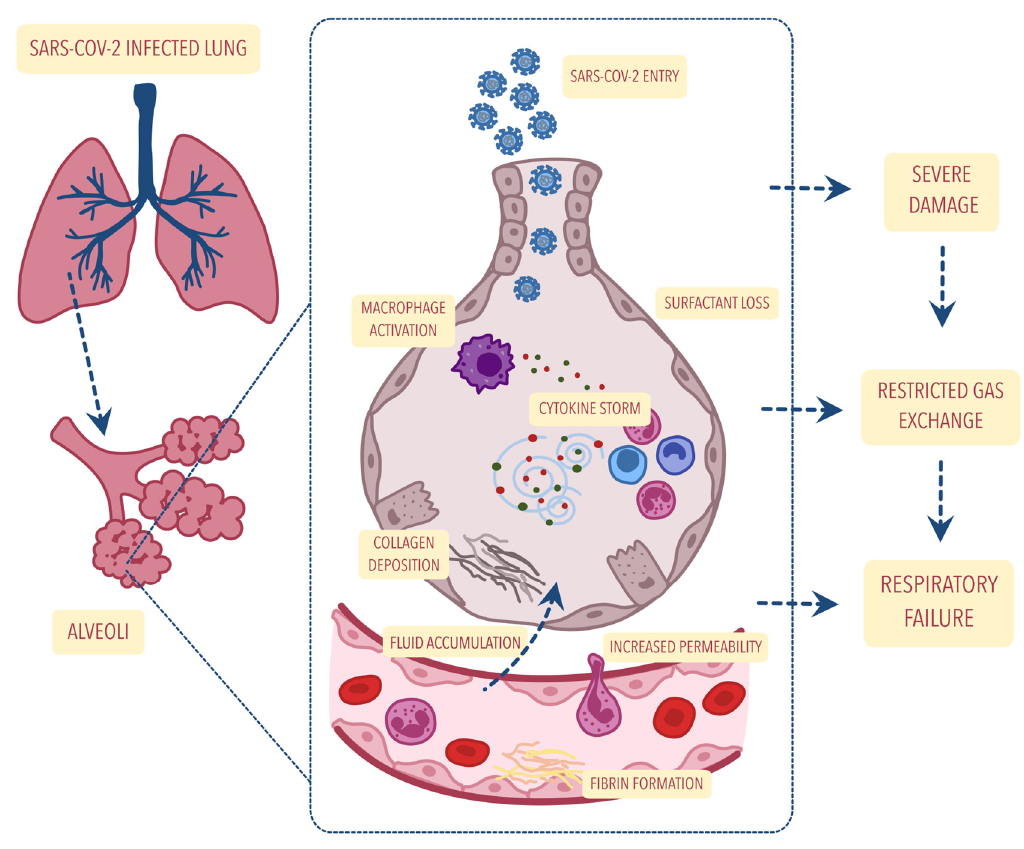
Figure 1. Alveolar changes in the course of COVID-19 leading to severe damage. This then leads to limited gas exchange resulting in respiratory failure. The figure was created using the Vectornator application (version 4.11.4 for iOS, accessed on 25 October 2022).